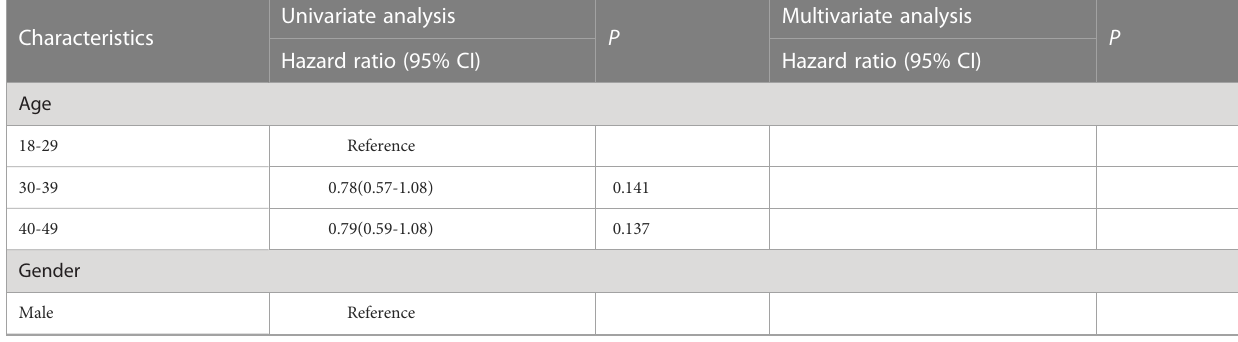
TABLE 2 Univariate and multivariate cox regression analysis of overall survival in the training cohort.